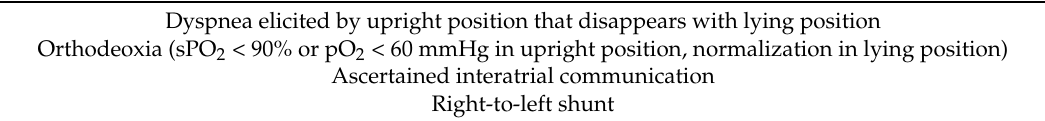
Table 2. Possible criteria for platypnea–orthodeoxia